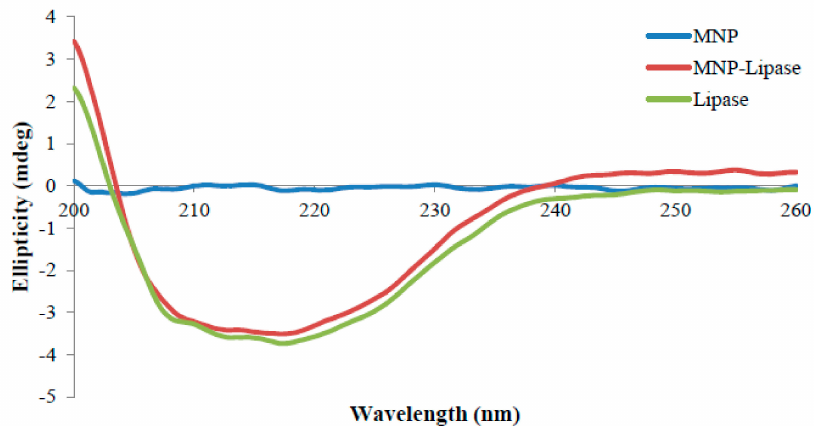
Figure 3. CD spectrum of functionalised magnetic nanoparticle (MNP), nanoparticle immobilised lipase (MNP-Lipase) and free lipase. Footnote: CD spectra of the functionalised magnetic nanoparticle (MNP),